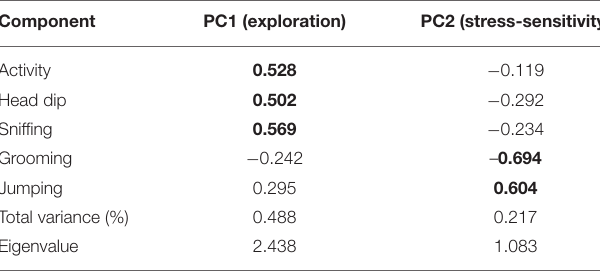
TABLE 1 | Correlation of each behavior observed during the hole-board test with the axes resulting from the principal component analysis.